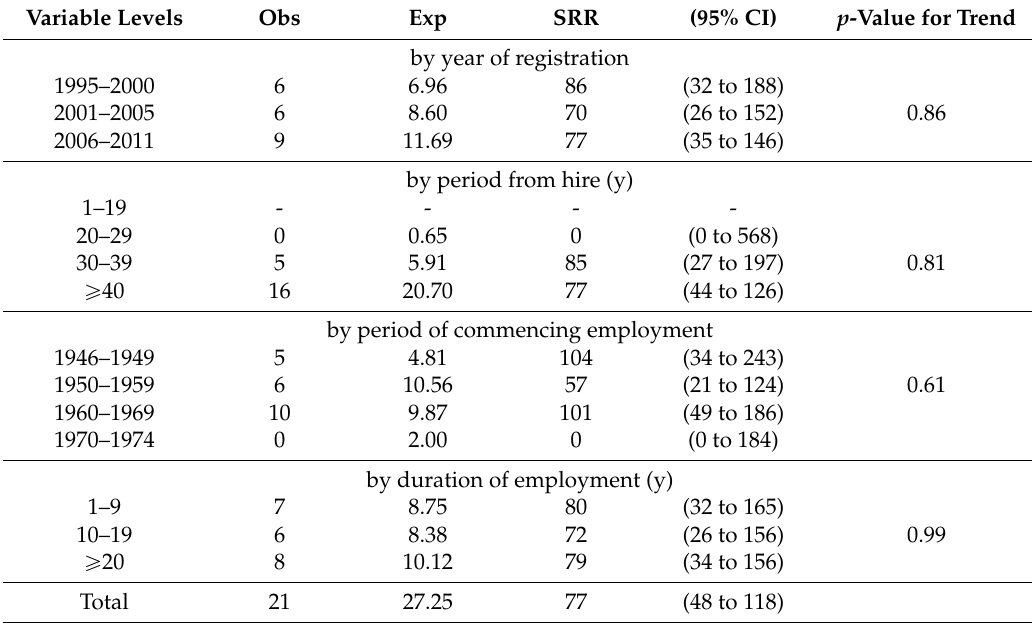
Table 2. Incidence of myelodysplastic syndrome (MDS) (ICD-10:D46) in 16,467 UK petroleum distribution workers, ages 15–99 years, 1995–2011.